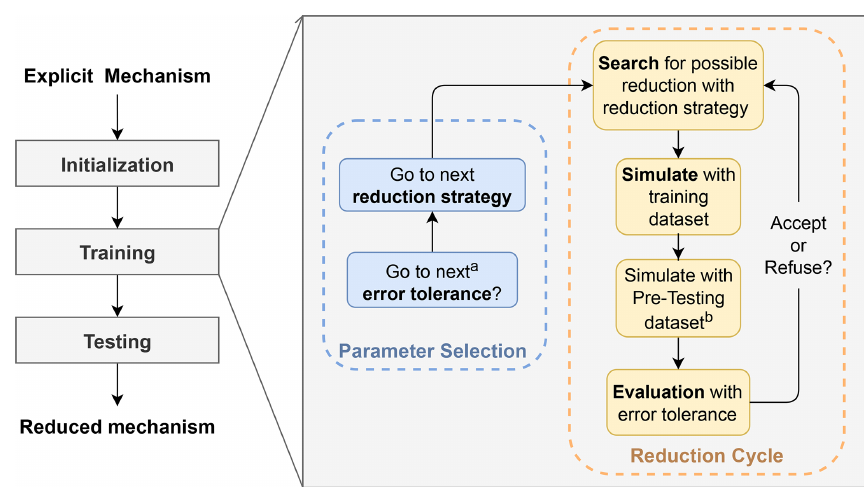
Figure 1. Flow chart indicating the three major procedures in GENOA and illustrating the main execution of the training section. a GENOA uses the first value of the targeted variables for initialization and then passes to the next values for subsequent parameter updates. b Simulation with the pre-testing dataset is only activated under certain